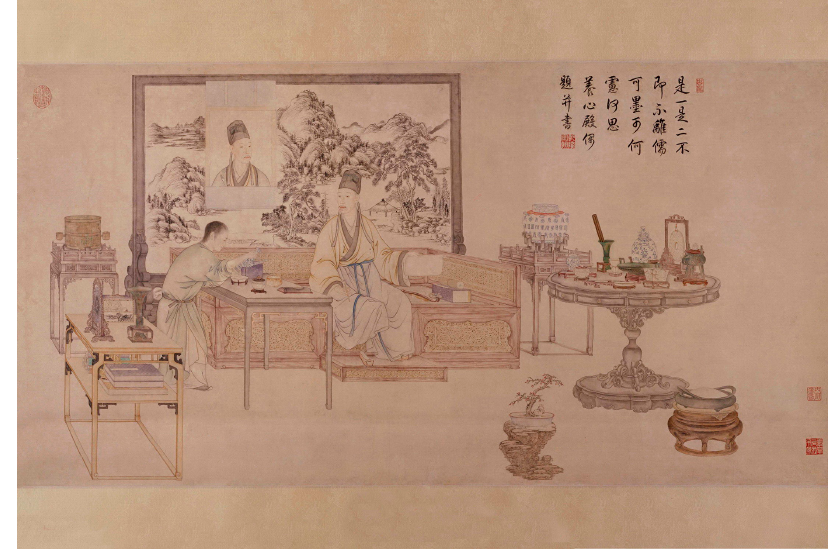
Figure 7. Ding Guanpeng (Qing Dyansty). Emperor Qianlong Appreciating Antiques in front of His Own Portrait . Ink and colors on silk. (76.5 × 147.2 cm). Palace Museum Collection,